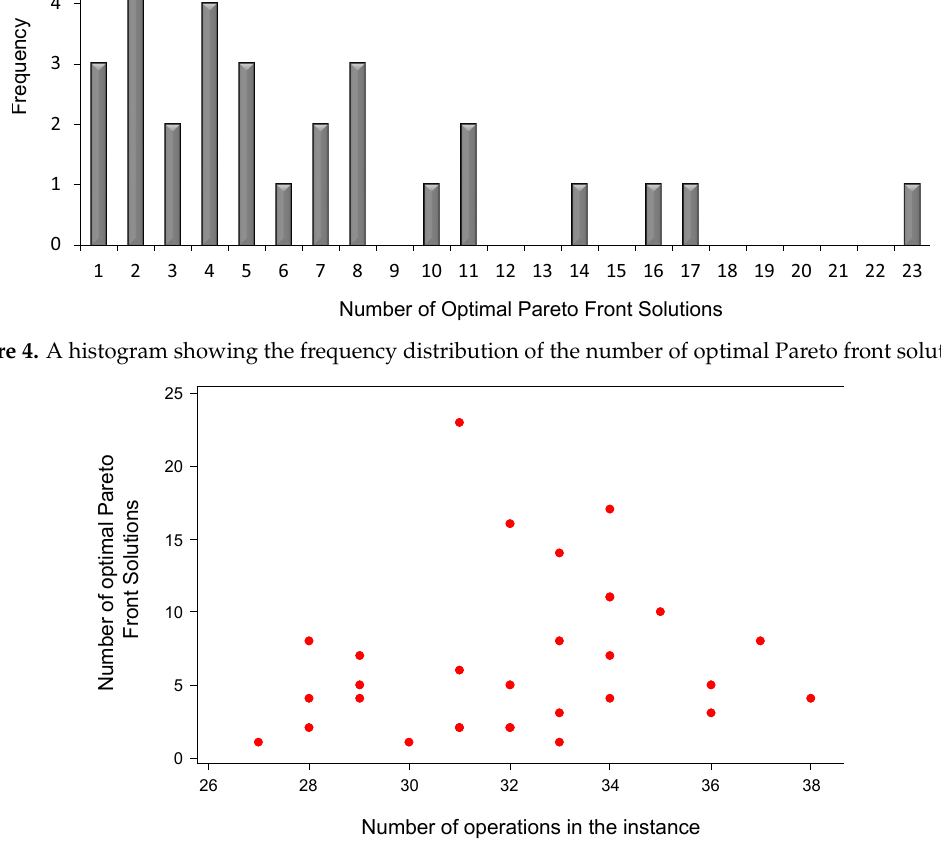
Figure 5. A scatter plot for the number of optimal Pareto front solutions versus the size of the